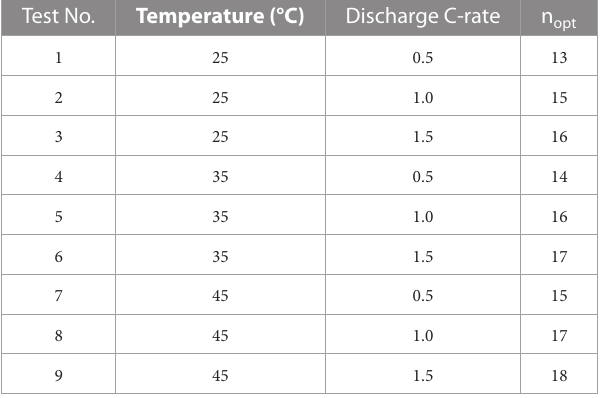
TABLE5 Optimal n foreachtestconditionforUMDCALCEdataset. Test